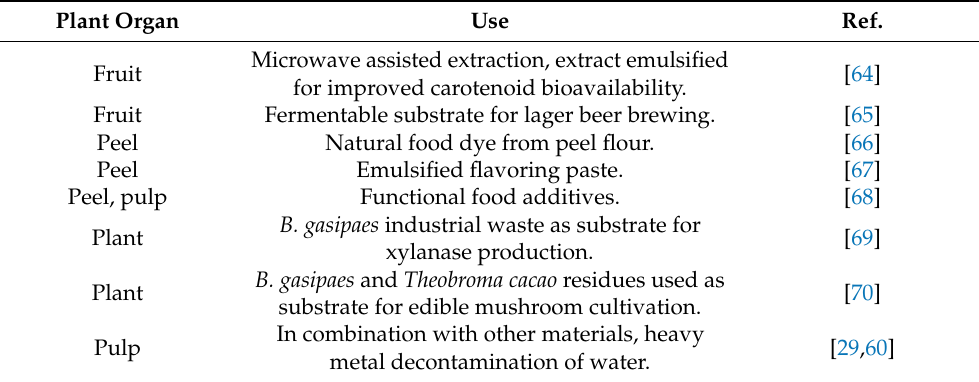
Table 3. Modern uses for B. gasipaes